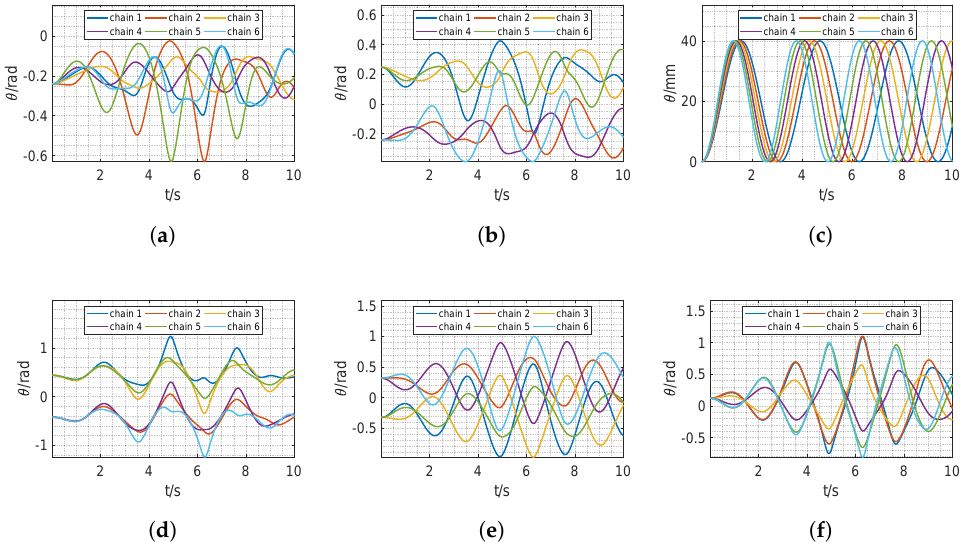
Figure 6. Joint displacements vs. time for all chains; ( a ) joint 1; ( b ) joint 2; ( c ) joint 3; ( d ) joint 4; ( e ) joint 5; ( f ) joint